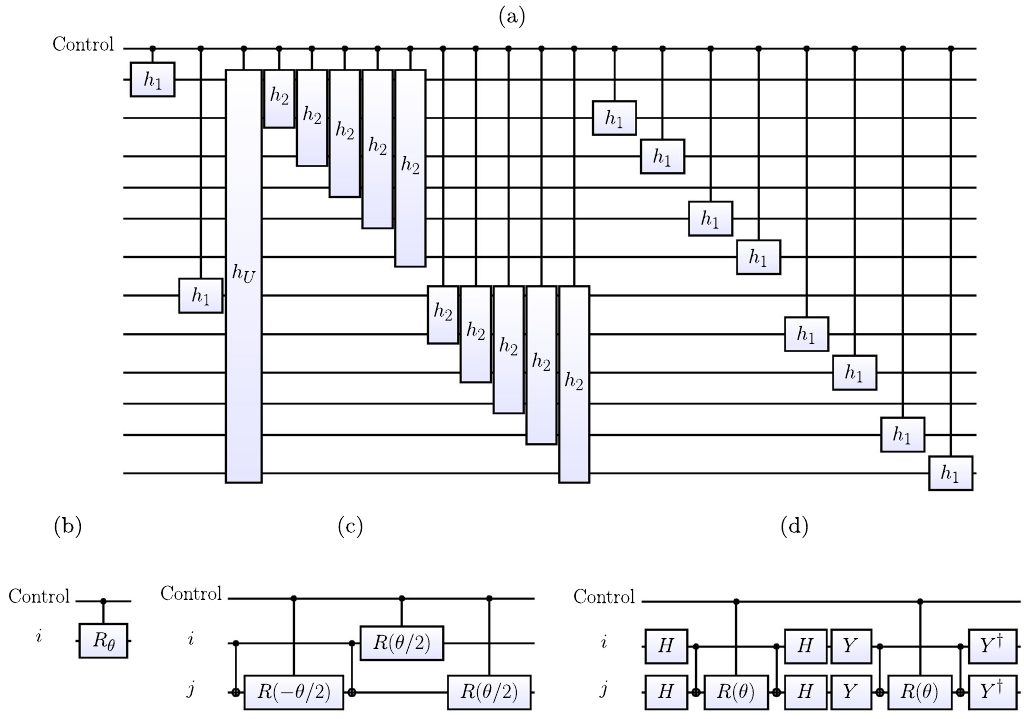
FIG. 5. (a) High-level overview of one step of the Trotterized time evolution. (b) Circuit h 1 ¼ exp ð − iT ε c † i c i Þ . (c) Circuit h ¼ exp ð − iTUn n Þ , where θ ¼ TU= 2 . (d) Circuit h U i j does not require a Jordan-Wigner